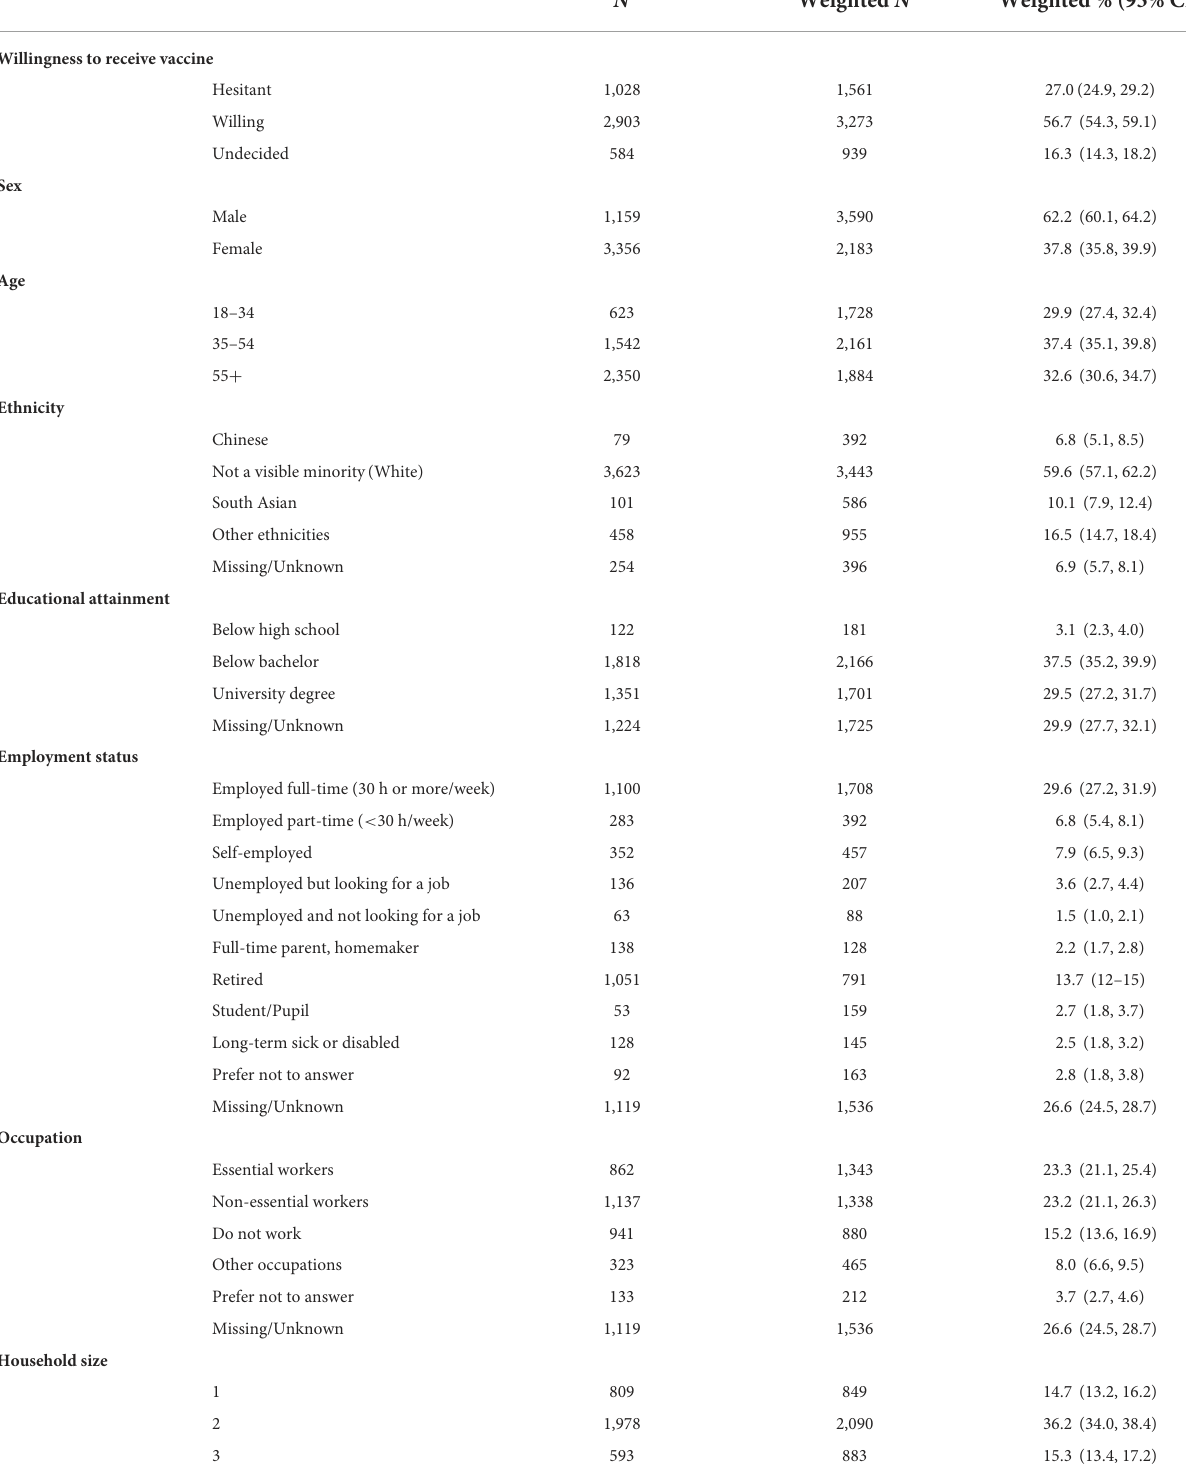
TABLE 1 Characteristics of study participants (unweighted N = 4,515), March 8, 2021-December 6, 2021. N Weighted N Weighted % (95%